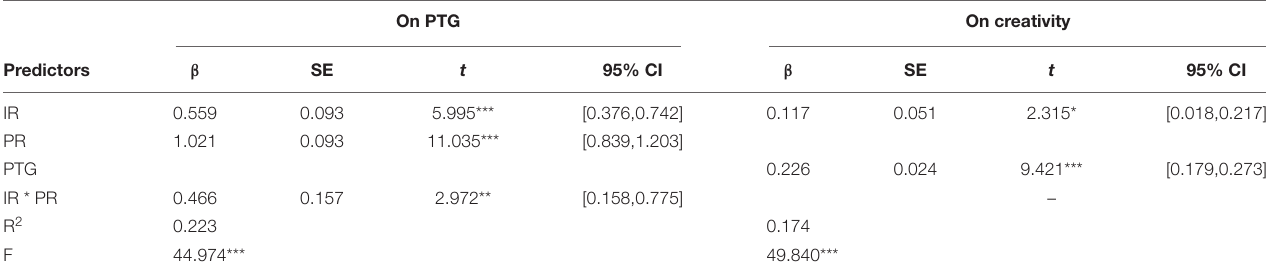
TABLE 5 | Moderated mediation test ( N = 475). On PTG On creativity